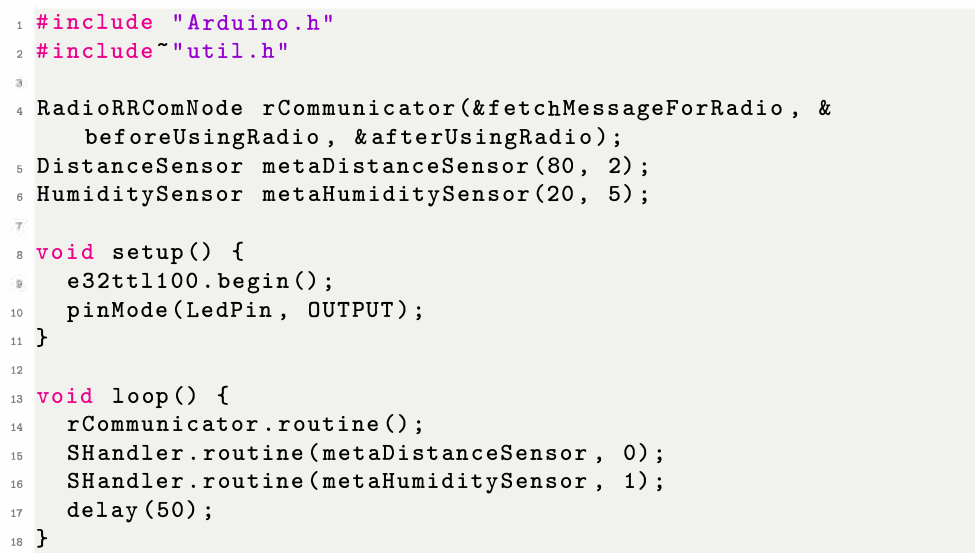
Figure 11. Monitor subsystem using our framework. The user needs fewer than 20 lines of code to obtain a working subsystem with all the advantages provided by the